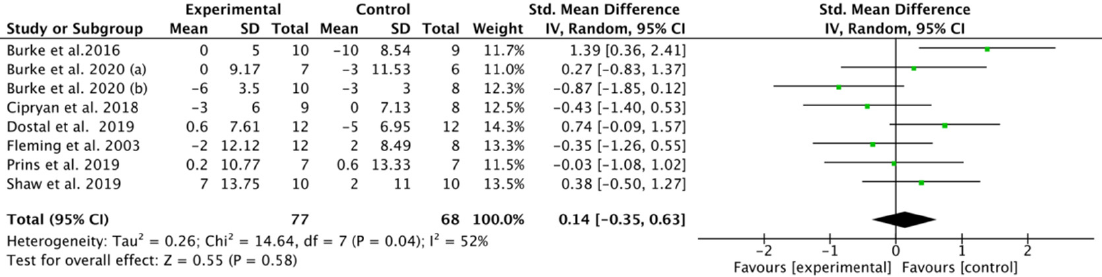
Figure 5. Effect of the ketogenic low-carbohydrate, high-fat (K-LCHF) diet on maximal heart rate (HRmax) during graded exercise test (GXT); CI: confidence interval; SMD: standardized mean difference.